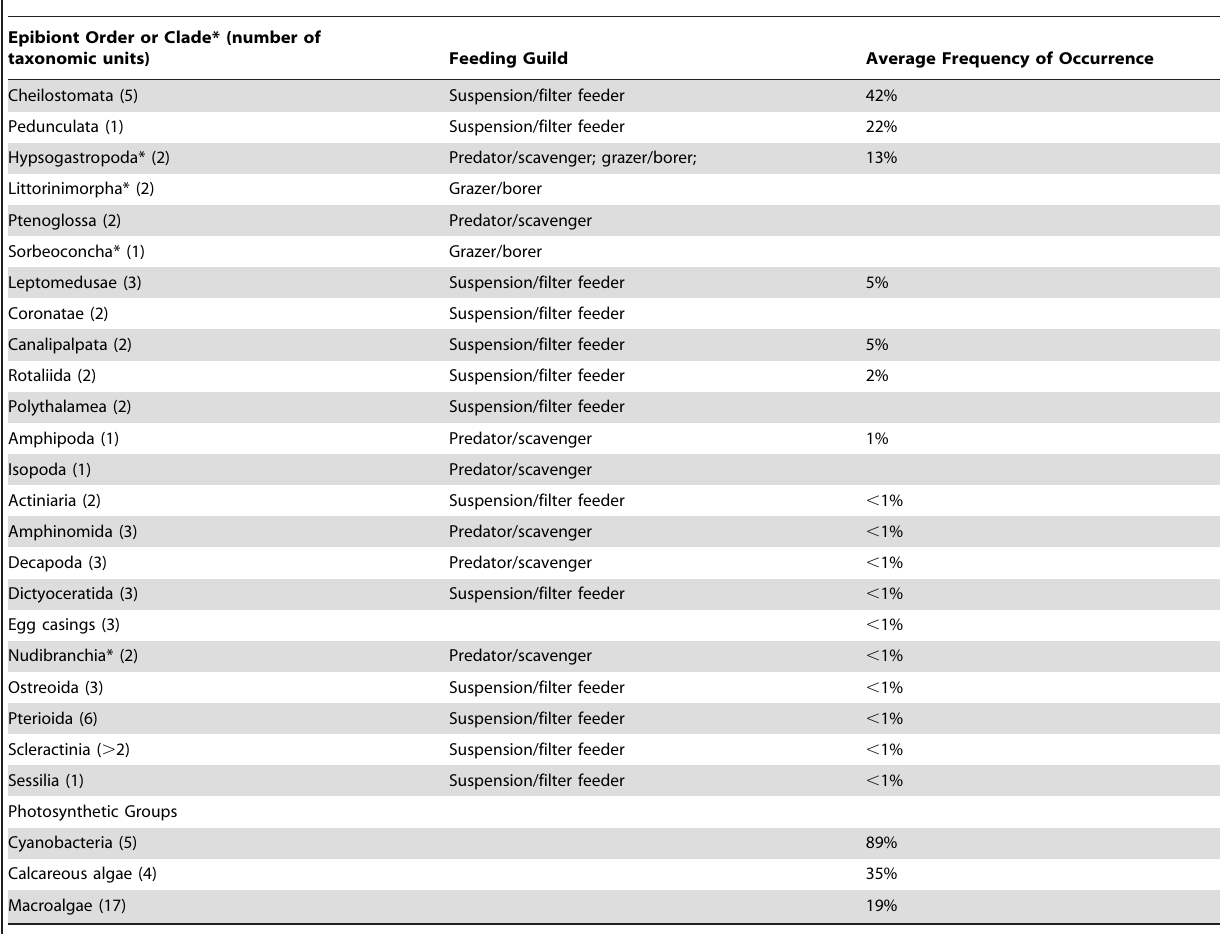
Epibiont Order or Clade* (number of taxonomic